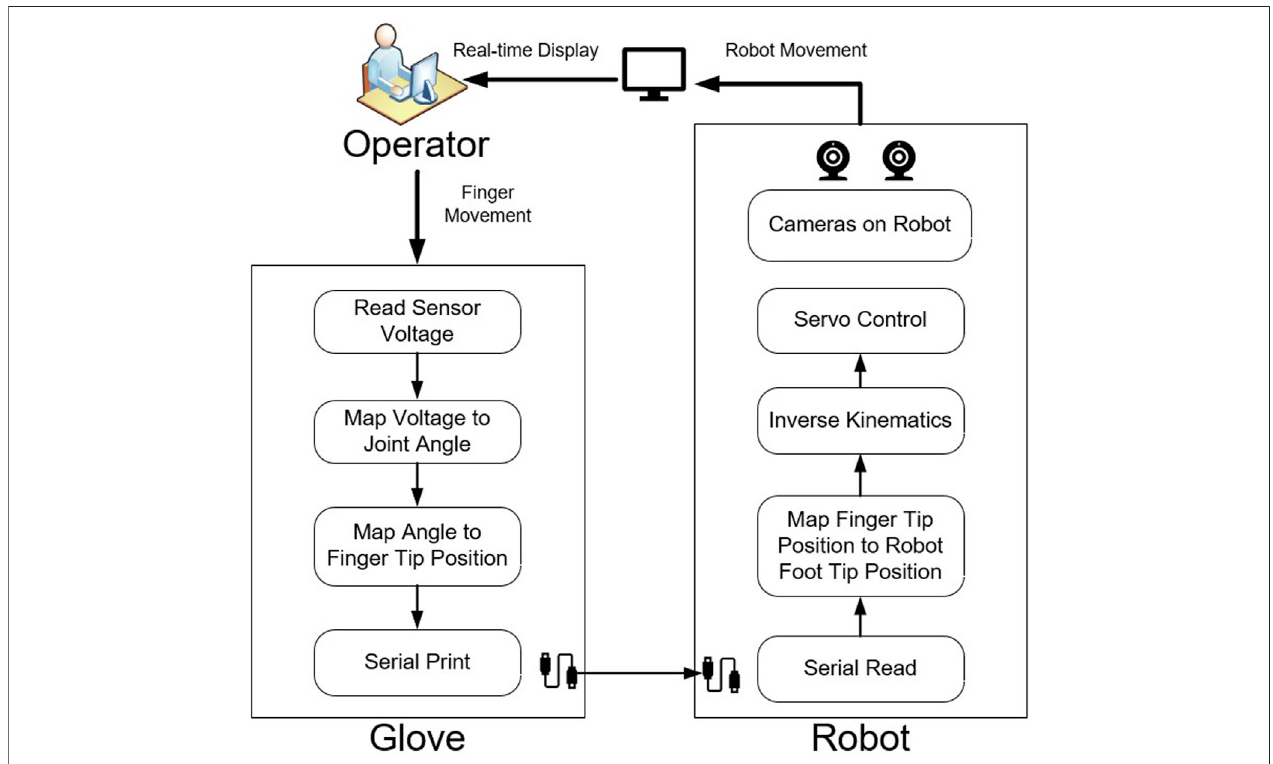
FIGURE 10 | The work fl ow of the TPM glove control